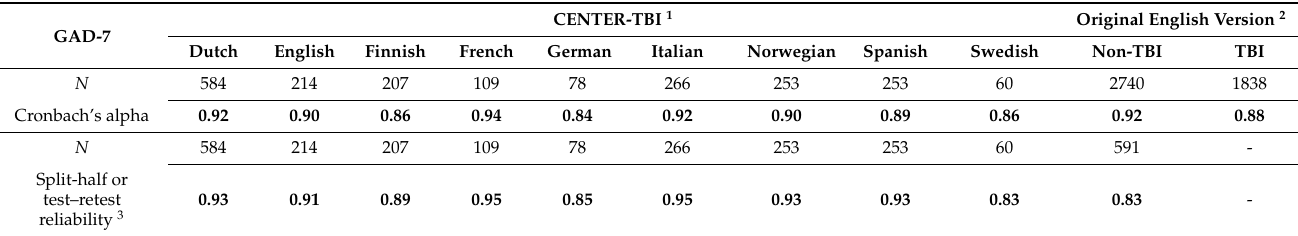
Table 1. Reliability of the GAD-7: Comparison of the CENTER-TBI results with the values from the original English validation study and the first English validation study in the field of